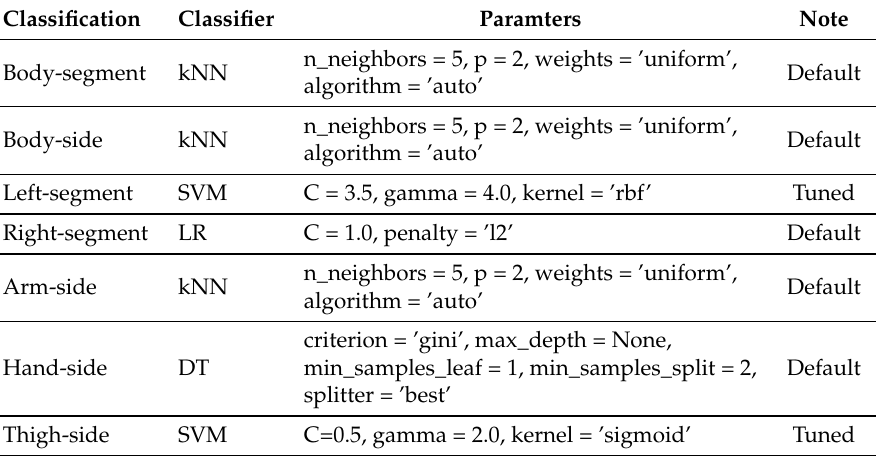
Table 10. Parameters of selected classifiers using